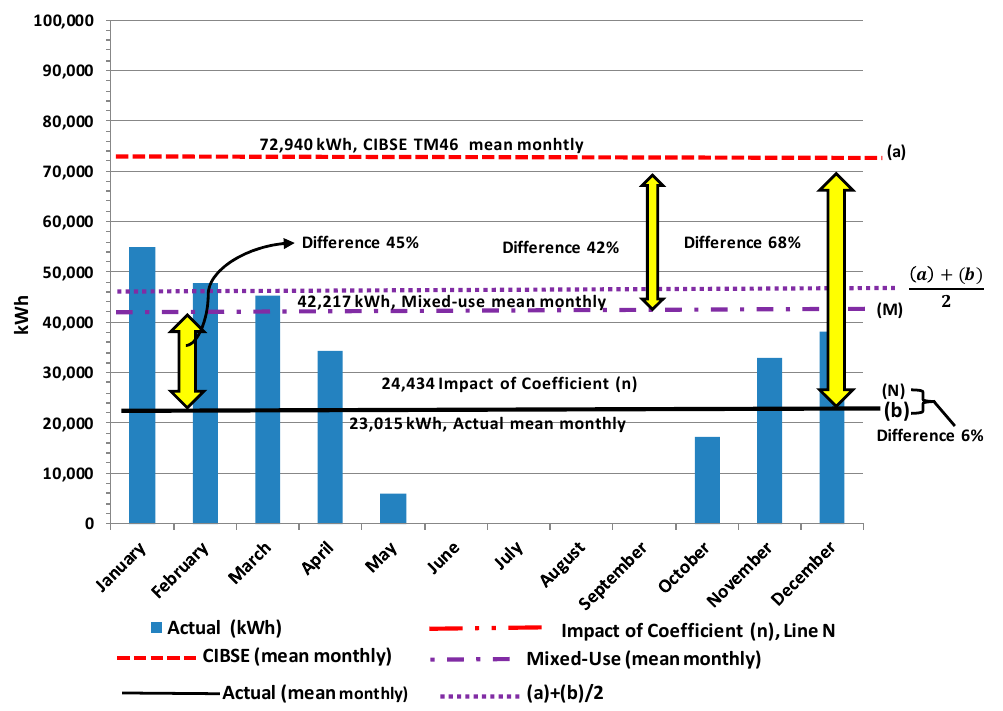
Figure 3. CIBSE TM46 UC and mixed-use model for thermal estimation against the actual data, Aras An Phiarsaigh building, Trinity College Dublin (TCD) campus 2014.